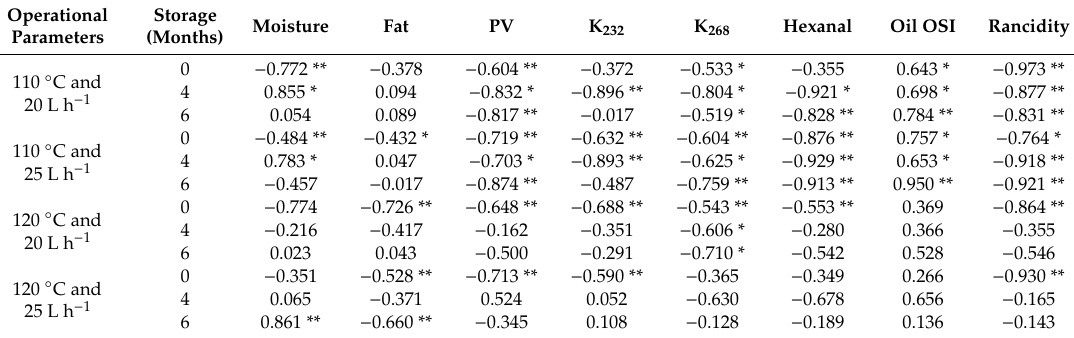
Table 4. Correlations between kernel oxidative stability (kernel OSI) and quality and oxidative parameters of the walnut kernels and extracted oils during 6 months of